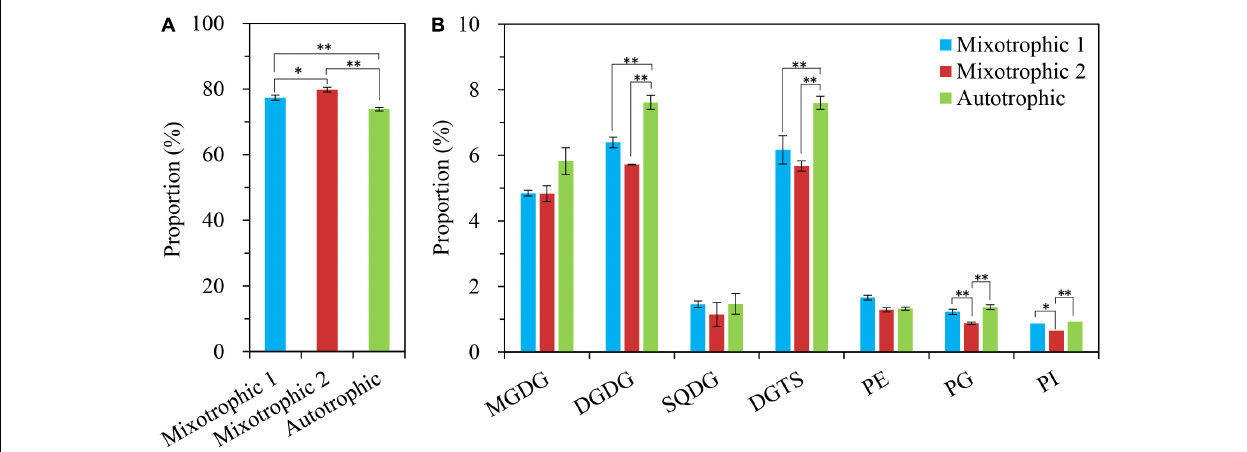
FIGURE 11 | Proportions (%) of the glycerolipid components in C. reinhardtii BAFJ5 under three carbon supply regimes at 48 h of HL-N. A: TAG; B: polar lipids. The carbon supply regimes for mixotrophic 1, mixotrophic 2, and autotrophic were 17 mM acetate and 2% CO 2 (v/v), 17 mM acetate and ambient 0.04% CO 2 (v/v), and 2% CO 2 (v/v), respectively. GL, glycerolipid; TAG, triacylglycerol; MGDG, monogalactosyldiacylglycerol; DGDG, digalactosyldiacylglycerol; SQDG, sulphoquinovosyldiacylglycerol; DGTS, diacylglycerol- N , N , N -trimethylhomoserine; PE, phosphatidylethanolamine; PG, phosphatidylglycerol; and PI, phosphatidylinositol. Values are means of three independent replicates ± SD ( n = 3). ∗ p < 0.05; ∗∗ p < 0.01.